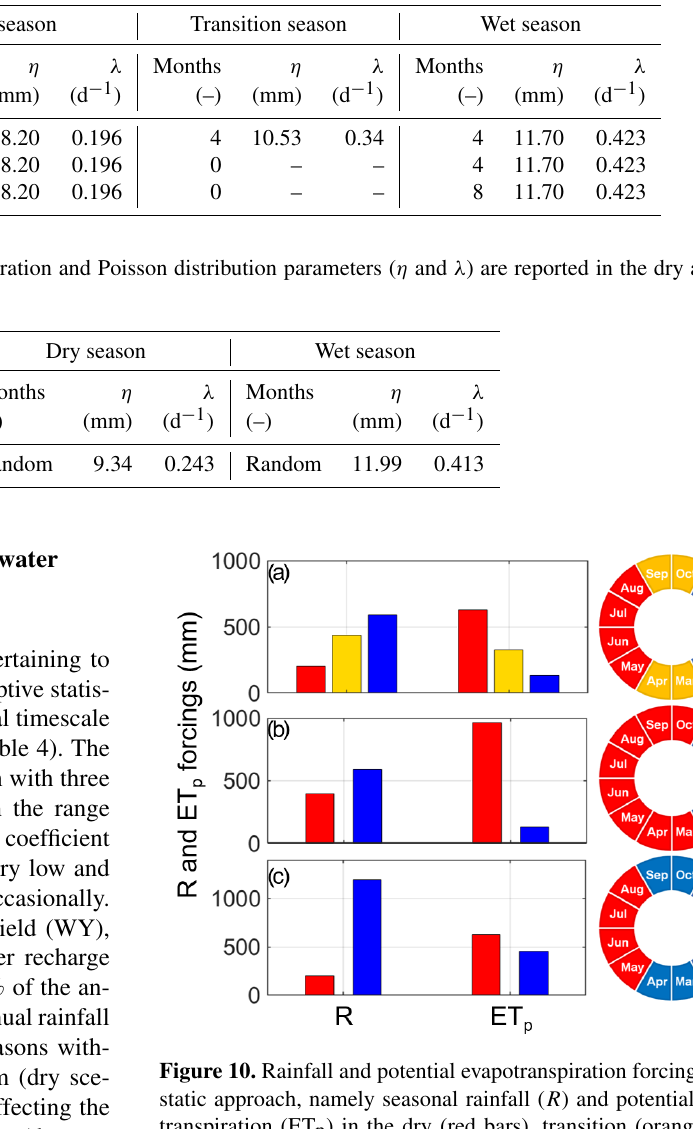
Table 2. Scenario setup in the static approach. Duration and Poisson distribution parameters ( η and λ ) are reported for each of the considered scenarios.